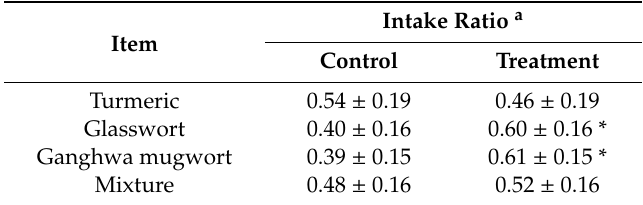
Table 4. Food preference of experimental diets with and without fermented turmeric, glasswort, Ganghwa mugwort, and their mixture in beagles.